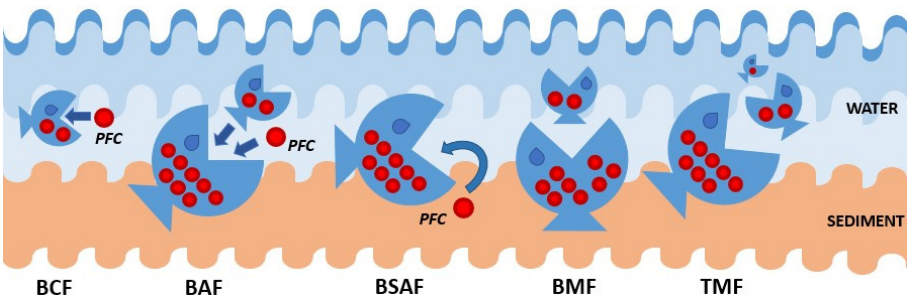
Figure 1. Illustration of bioaccumulation